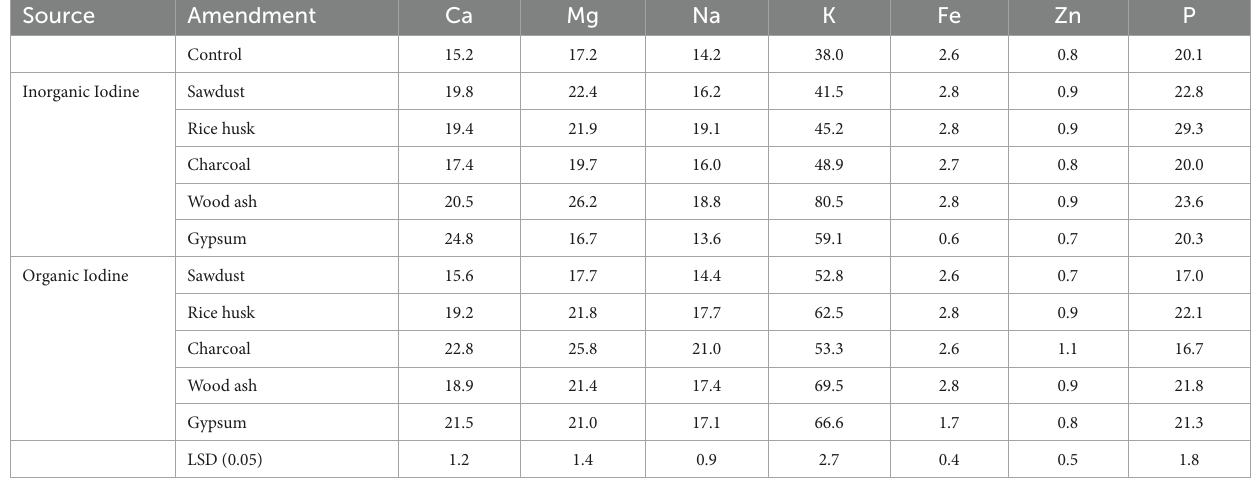
TABLE 5 Nutrient composition in coriander shoots as affected by soil